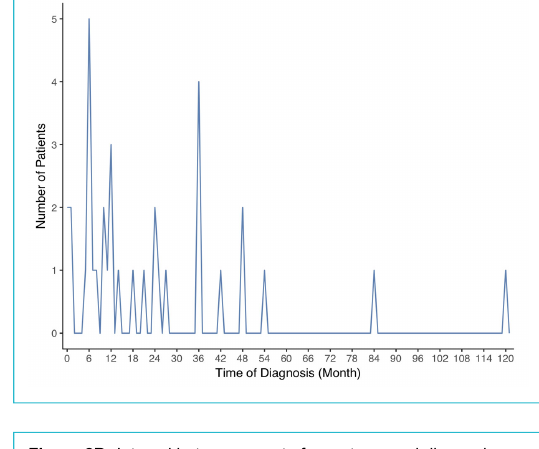
Figure 2B: Interval between onset of symptoms and diagnosis: cumulative share of the patients diagnosed with EHH in the course of